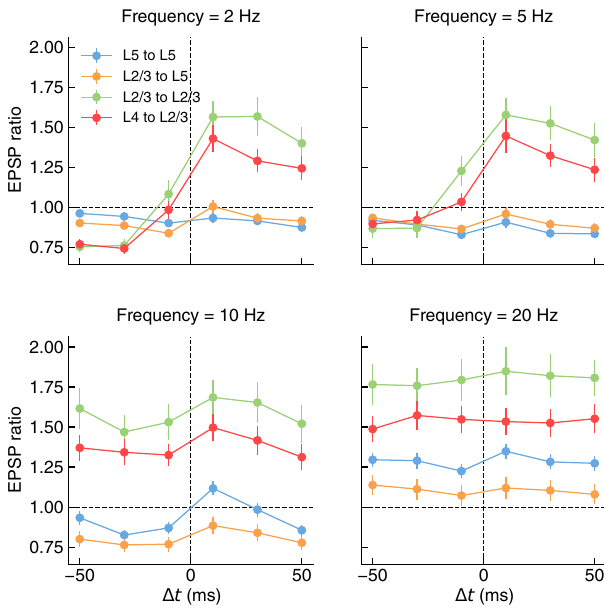
Fig. 6 Diversity of in silico STDP across stimulation frequencies and connection-types. Plasticity at connections between L5-TTPC to L5-TTPC (blue, n = 100), L2/3-PC to L5-TTPC (orange, n = 99, due to an excluded outlier), L2/3-PC to L2/3-PC (green, n = 100) and L4-PC to L2/3-PC (red, n = 100) was induced following stimulation protocols in Markram et al. 40 to allow for a standardized comparison of STDP curves. Four different pairing frequencies were considered: 2 Hz (top left), 5 Hz (top right), 10 Hz (bottom left) and 20 Hz (bottom right). Data for L5-TTPC to L5-TTPC as in Fig 2. All panels report EPSP ratio data as mean ± SEM. For the full distribution of in silico experiment outcomes see SI A.10 (L5-TTPC to L5- TTPC), A.16 (L2/3-PC to L5-TTPC), A.17 (L2/3-PC to L2/3-PC), A.18 (L4- PC to